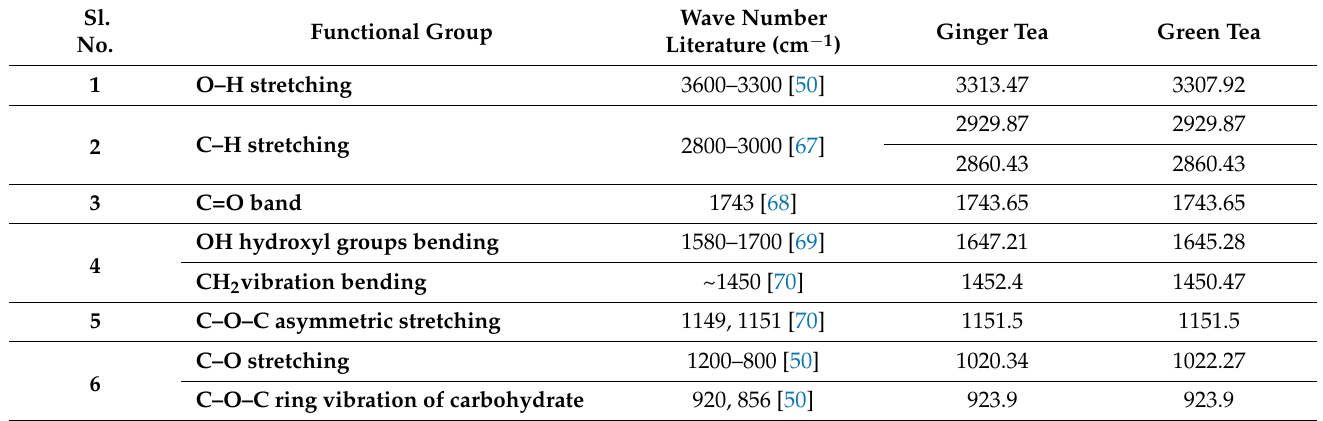
Table 3. Band assignment of ginger tea and green tea